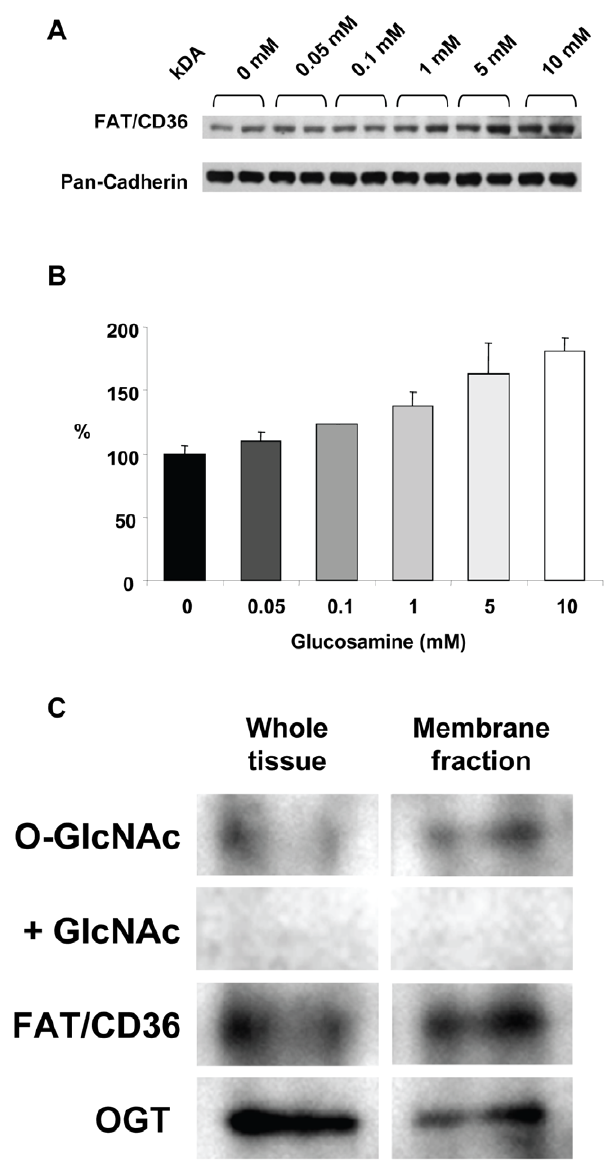
Figure 5. A) Immunoblots of Plasma membrane fraction for FAT/CD36 following 60 min perfusion with 0, 0.05, 0.1, 1, 5 and 10 mM; pan-cadherin included as a plasma membrane marker and protein loading control; B) Densitometric analysis of FAT/ CD36 immunoblots normalized to 0 mM glucosamine; P , 0.05 vs. 0 mM, one-way ANOVA with Dunnett’s posthoc test; n=2in eachgroup ; C) Immunoprecipitation of FAT/CD36 from whole tissue and plasma membrane lysates, followed by O-GlcNAc and OGT immunoblots. Specificity of O-GlcNAc antibody was confirmed by co-incubation with 10 mM N-acetylglucosamine (GlcNAc).